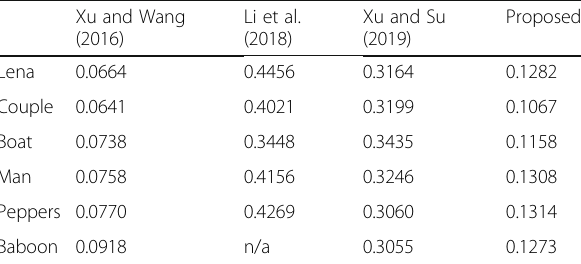
Table 6 Operation time comparisons among four methods during the embedding process. (unit:s) Xu and Wang